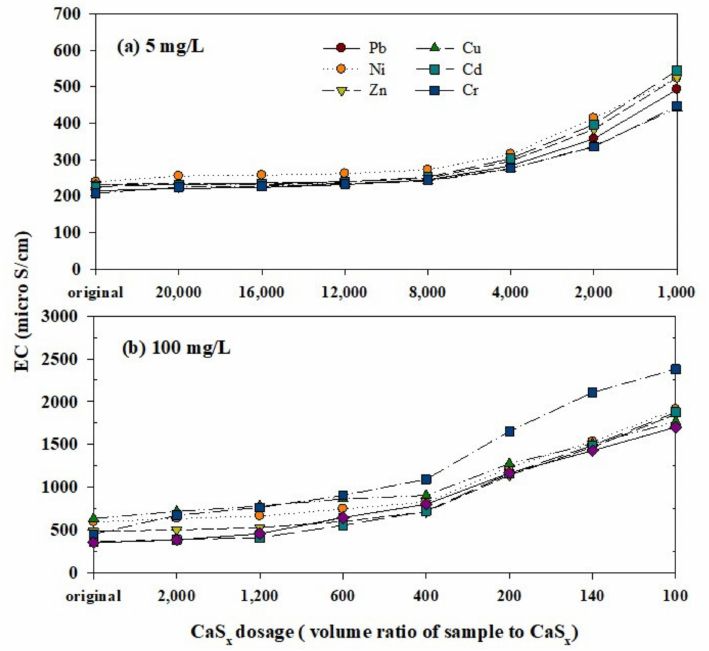
Figure 4. The variation in EC of various metal aqueous solutions when different dosages of calcium polysulfide were added, ( a ) for concentration of 5 mg/L, ( b ) for concentration of 100